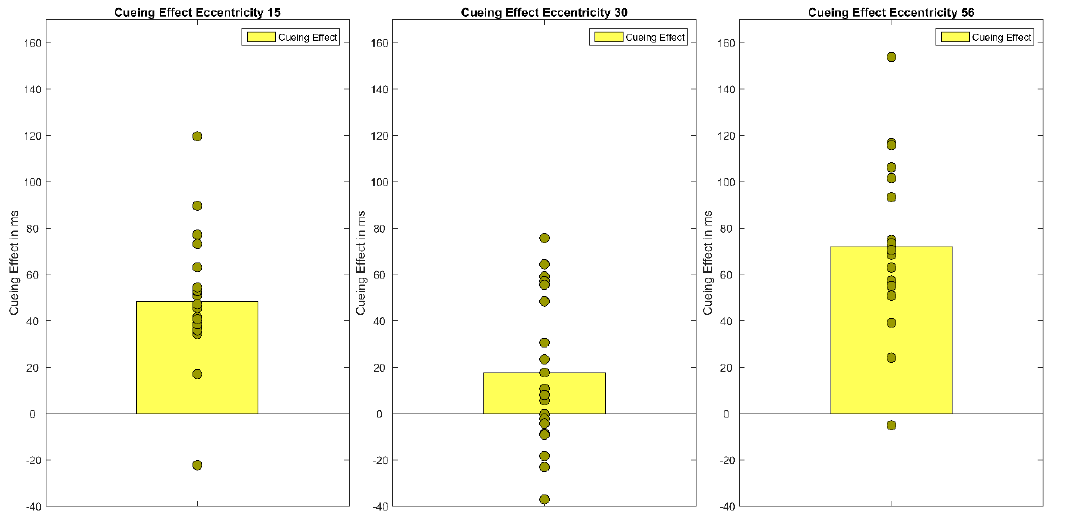
Figure 3. The figure shows the cueing effects (invalid RT-valid RT) for each eccentricity (15°, 30°, 56°). Bars show the mean of cueing effects across participants. Filled circles show the cueing effects of each individual participant.